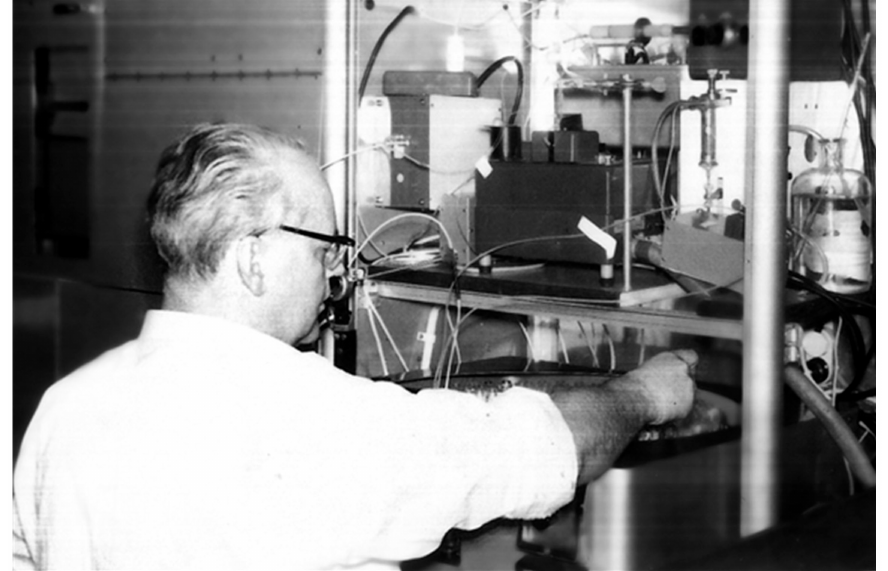
Figure 6. Gunnar Jungner working with a unit in Stockholm in